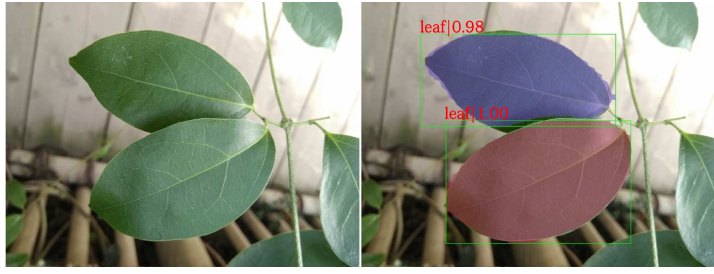
Figure 6. Result of